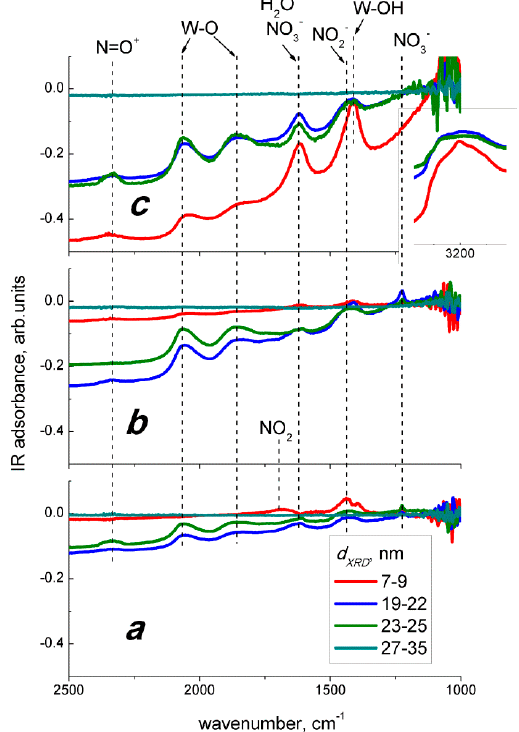
Figure 9. DRIFT spectra of WO 3 with different grain size exposed to 2 ppm NO 2 in dry air at 25 °C ( a ), in dry air at 100 ° С ( b ), and in 90% r.h. humid air at 100 ° С ( c ).